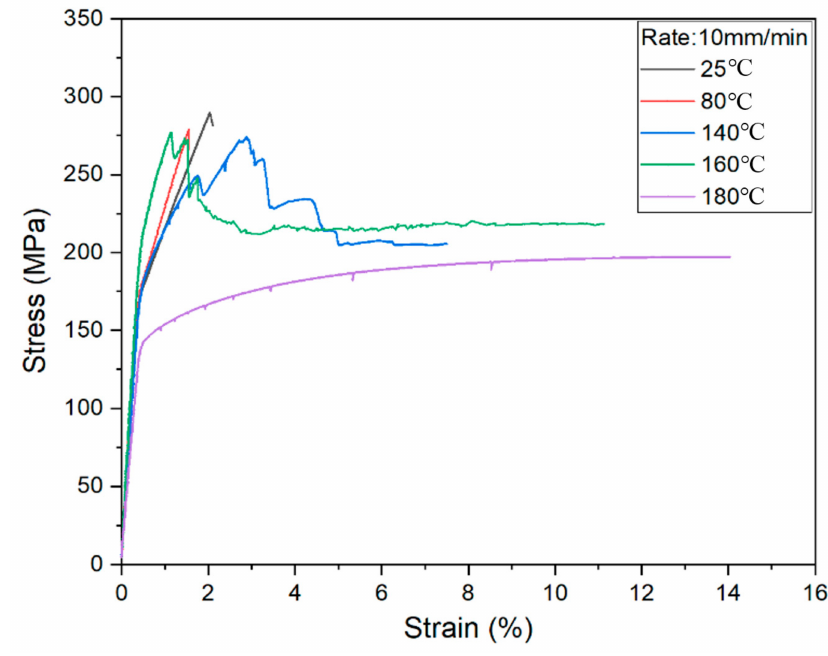
Figure 4. Stress-strain curves under 10 mm/min stretching